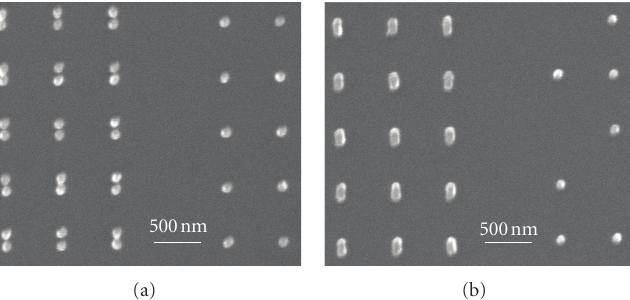
Figure 4: SEM images of the specifically designed samples. Alternations between three lines of the investigated dimers and two lines of reference monomers are made. All nanoparticles are 100nm in diameter. In (a), the dimer’s separation gap is 30nm, and in (b) the dimers have no gap (i.e., contact). The mutual distance between two dimers (center to center) is fixed at 600 nm in both